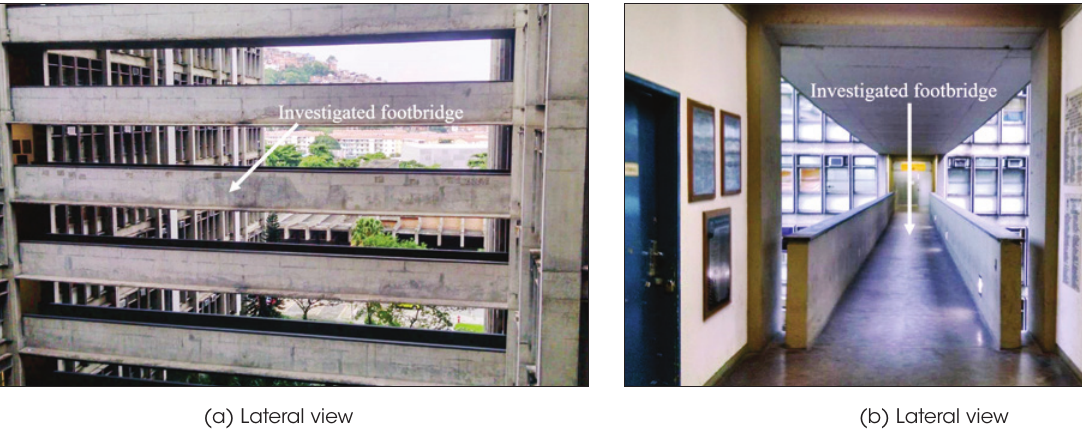
(a) Lateral view (b) Lateral